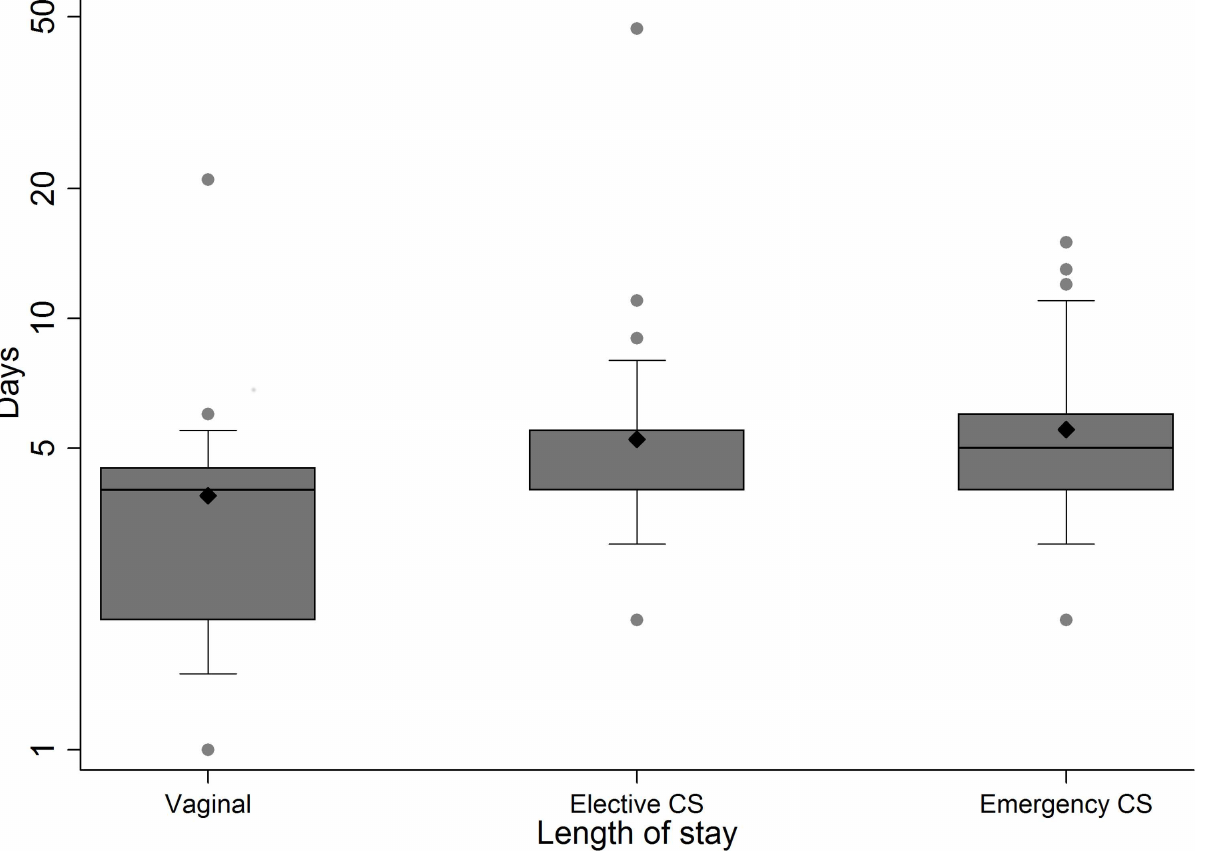
Fig 3. Boxplot with mean ( ◆ ) for length of stay for women by delivery mode. For elective CS, the median is equal to the lower quartile. Abbreviations: CS = Caesarean